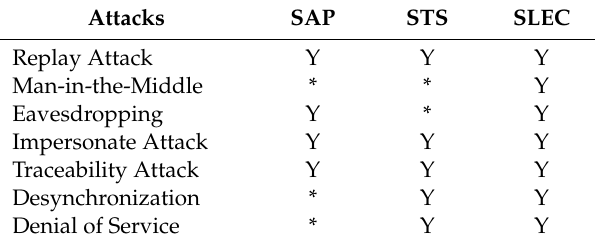
Table 3. Comparison of Security Resistance.